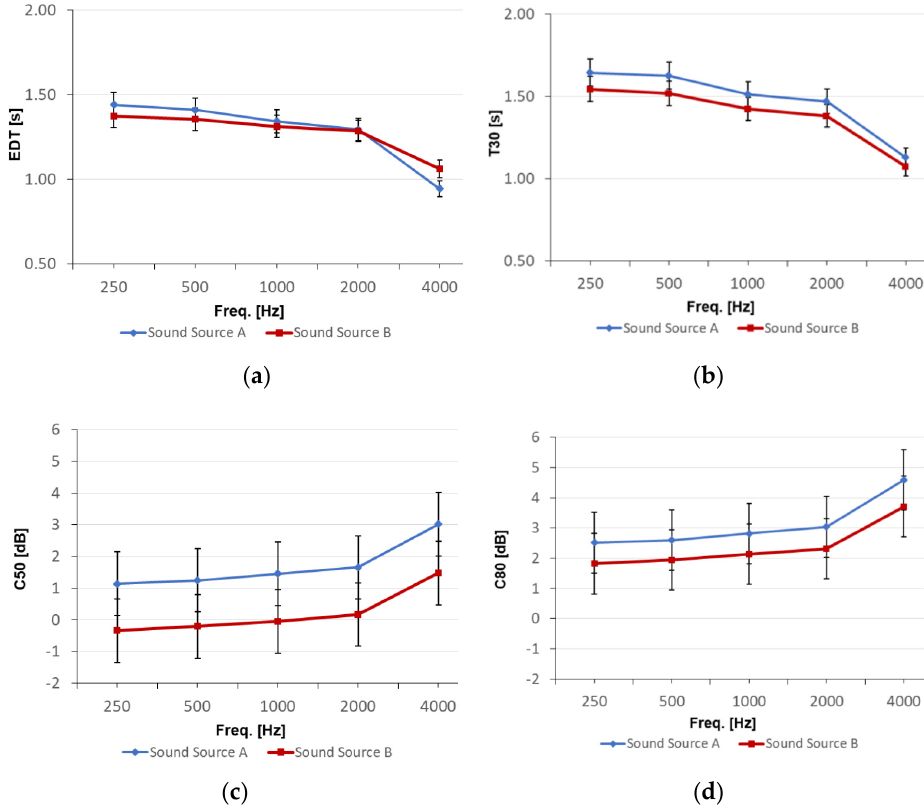
Figure 15. Comparison of the average acoustic parameters (( a ) EDT, ( b )T30, ( c ) C50, and ( d ) C80) simulated with receivers and audience in the Prince’s box and the two sound sources A and B on the stage. The error bars (Just Noticeable Difference, JND) are reported for EDT and T30 (5%) and for clarity (1dB).